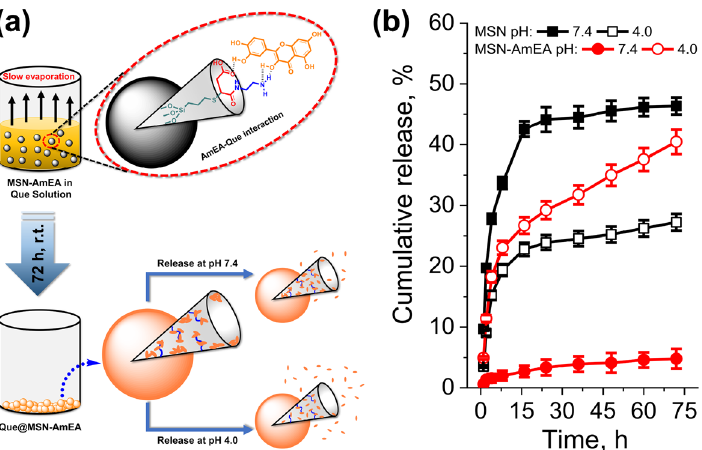
Figure 5. ( a ) The scheme illustrated the loading process of Que onto MSN-AmEA, and how they possibly interacted, also the representation of Que released from nanoparticles at pH 7.4 and 4.0 (created by using ChemDraw Professional version 20.0.0.41, https:// www. cambr idges oft. com/ Ensem ble_ for_ Chemi stry/ ChemO ffice/ ChemO ffice Profe ssion al). ( b ) The cumulative release profiles of Que@MSN and Que@MSN-AmEA at pH 7.4 and pH